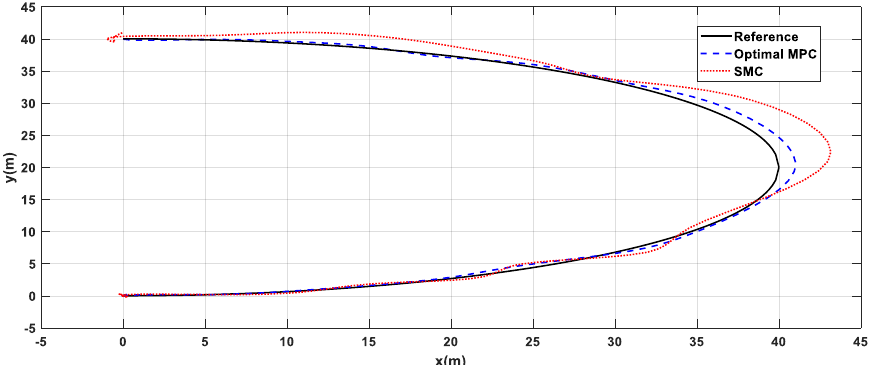
Figure 7. XY plane Figure 6.